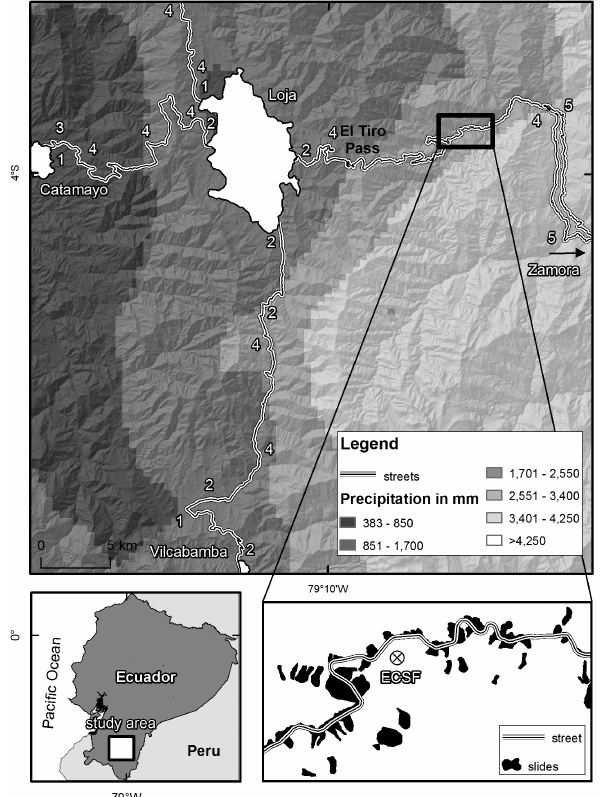
Figure 1. Overview of the study area with mean annual precipita- tion patterns (top panel), and its location in southern Ecuador (lower left panel). Highways Troncal de la Sierra E35 and Transversal Sur E50 extend in the north–south and east–west direction, respec- tively. The numbers along the street refer to the corresponding geo- logical unit (1: unconsolidated rocks; 2: sedimentary rocks; 3: vol- canic rocks; 4: metamorphic rocks; 5: plutonic rocks). The area of the detailed map (lower right panel) will be used as a sample area for the visualization of a predictive map in Fig. 5. Precipitation data are taken from the study of Rollenbeck and Bendix